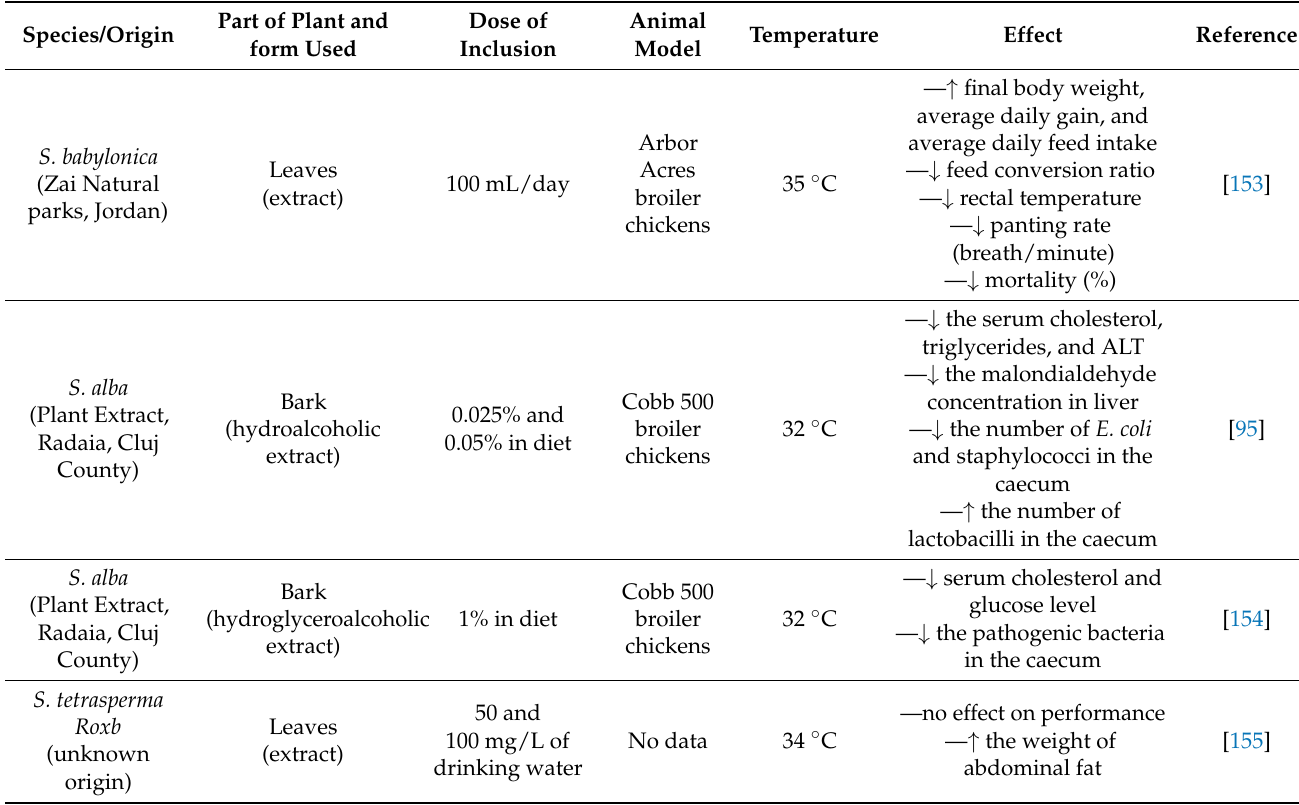
Table 4. Effects of dietary Salix (as bark or leaves) species on heat-stressed